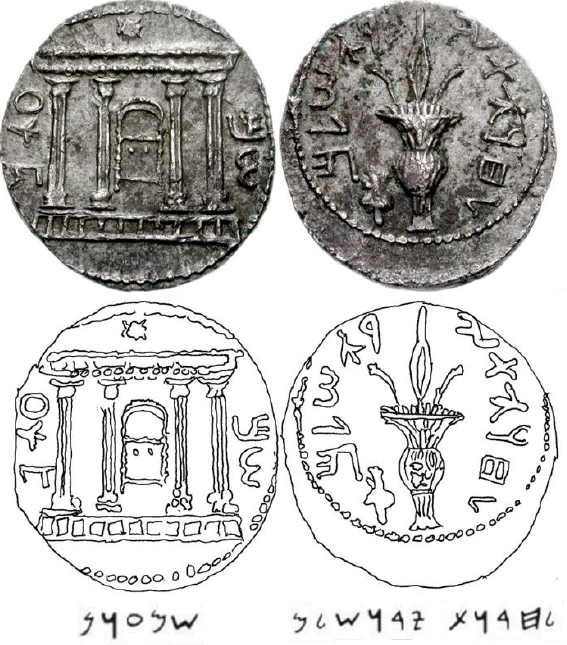
Figure 1. Bar Kokhba silver Shekel (134/5 CE). Obverse: the Jewish Temple facade with the rising star, surrounded by [ ןועמש ] ( “ Shimon ” ). Reverse: a lulav and etrog, the text reads: [ םלשורי תורחל ] ( “ to the freedom of Jerusalem ” ) (the script is palaeo-Hebrew: see Supplementary Materials for more information). Image: Classical Numismatic Group, Inc. http://www.cngcoins.com, CC BY-SA 3.0, https://commons.wikimedia.org/w/index.php?curid=2420146 (accessed 14 December 2022); Tracing: Margaret Barker.